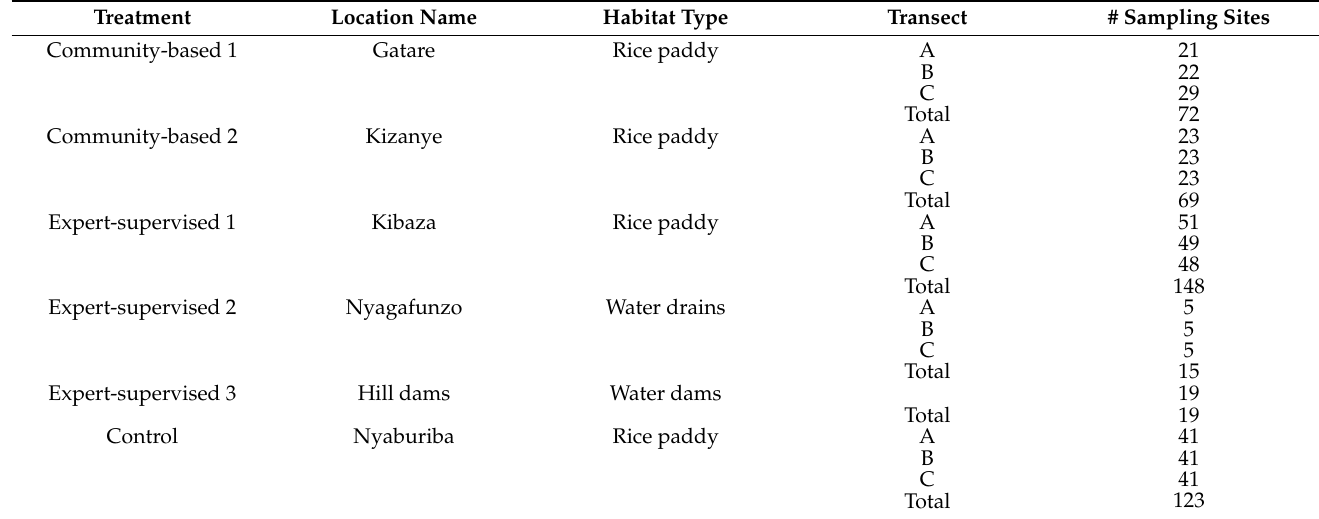
Table 1. Overview of the numbers of sampling points per transect per